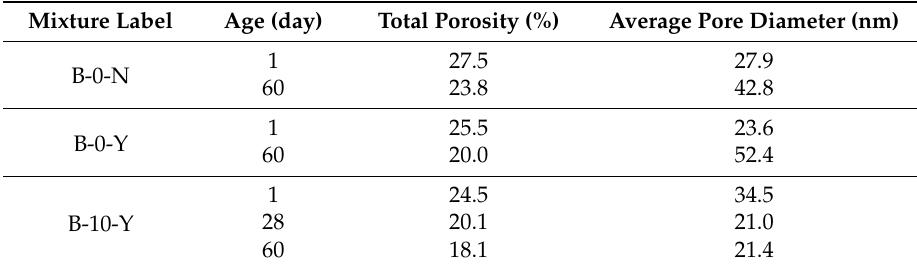
Table 5. The total porosity and average pore diameter of each mixture.